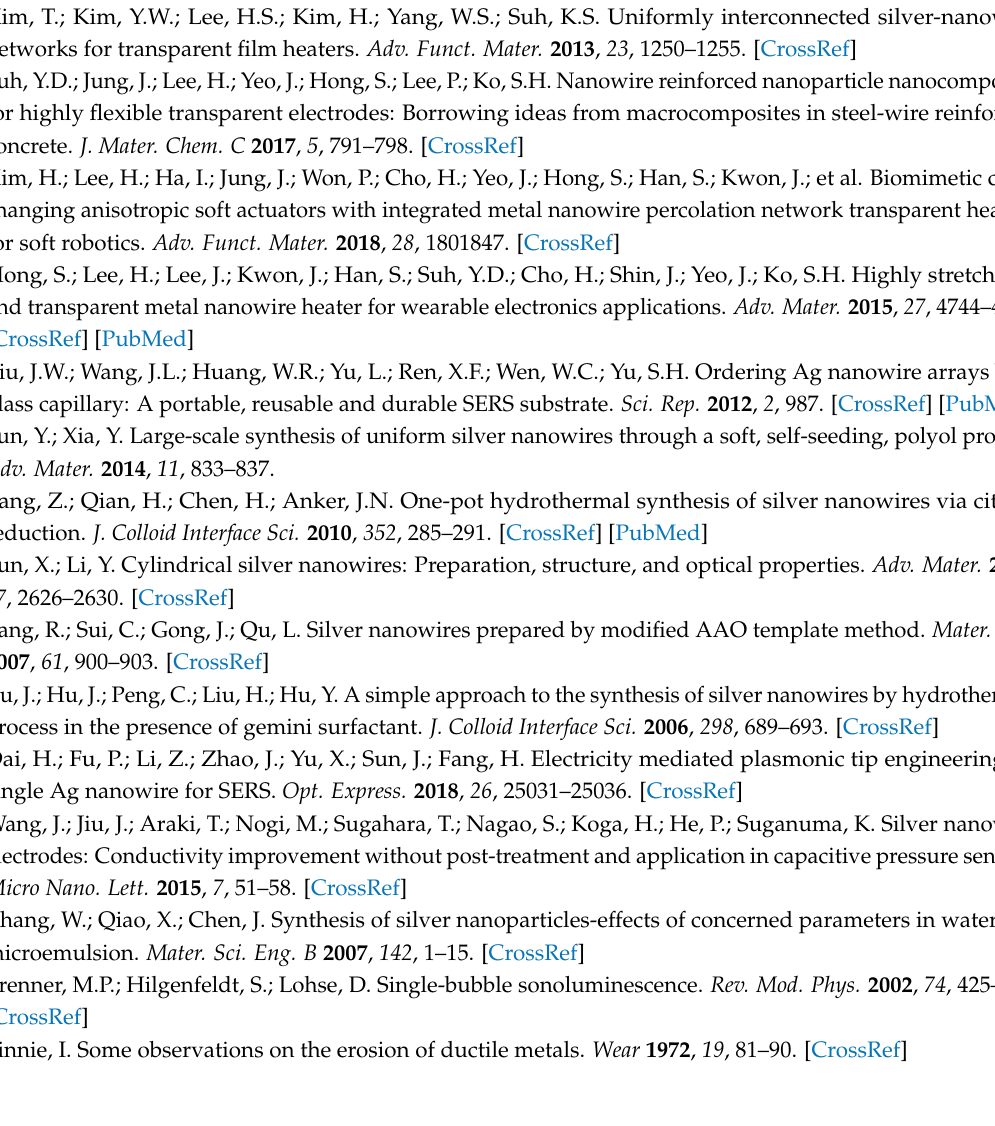
Figure S1: Optic image of the Ag nanowire films without ultrasonic treatment; Figure S2: SERS signals of Ag nanowires before and after 10 min ultrasonic treatment in other points; Table S1: Temperatures of A (center), B (between the center and margin), and C (margin) without treatment; Table S2: Temperatures of A (center), B (between the center and margin), and C (margin) with ultrasonic